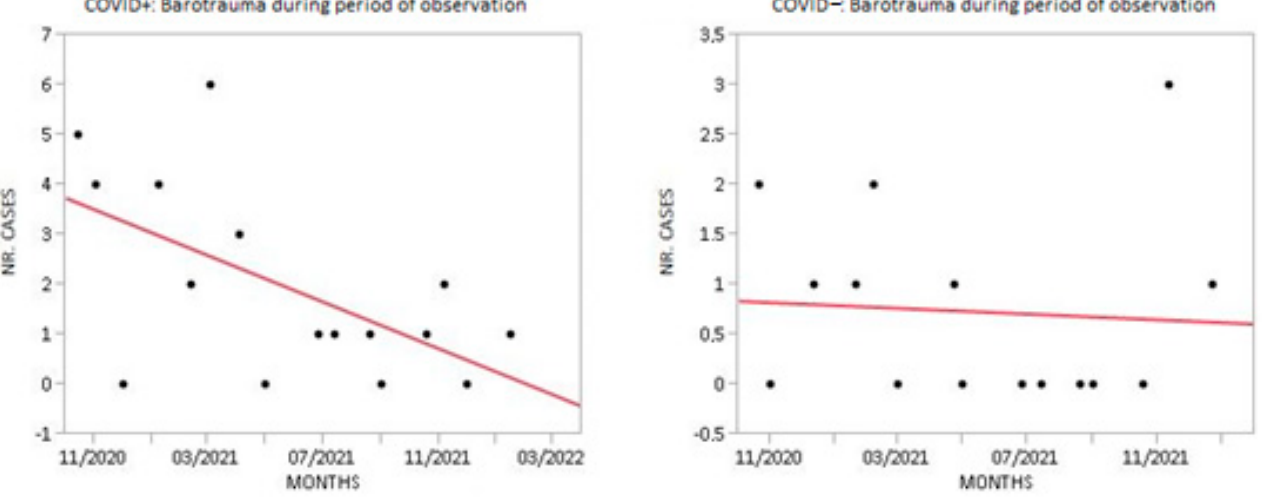
Figure 8. Cases of barotrauma in COVID+ group vs. COVD- group during period of observation.